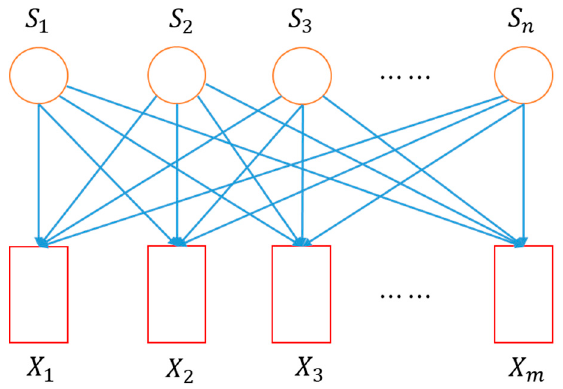
Figure 1. Diagram of multisource multi-sensor testing procedure.